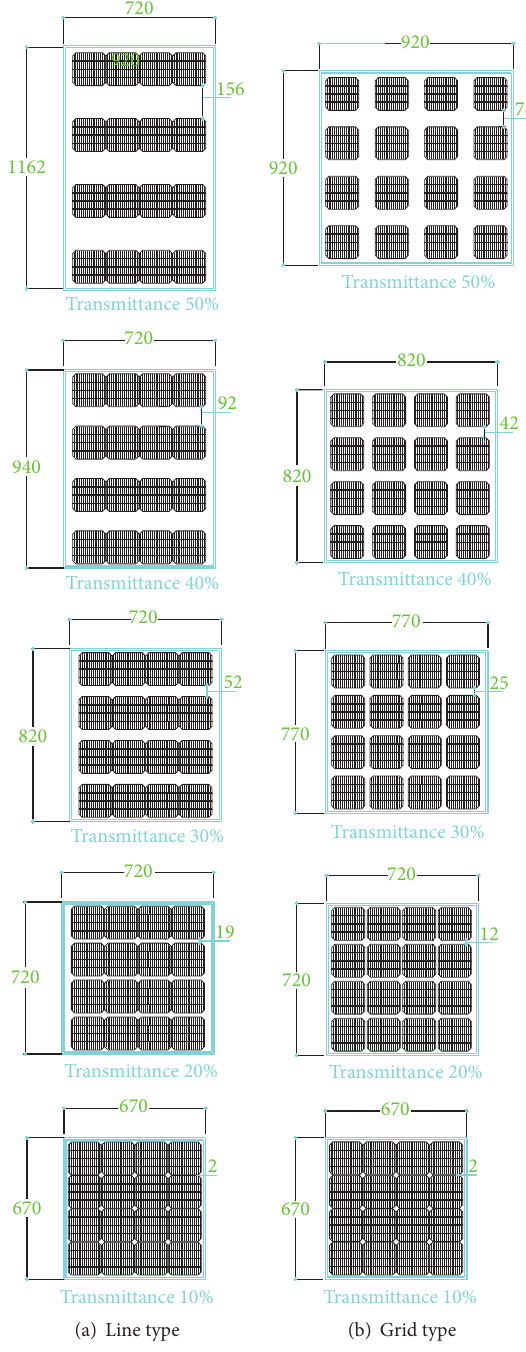
Figure 4: Module types according to the cell placement method